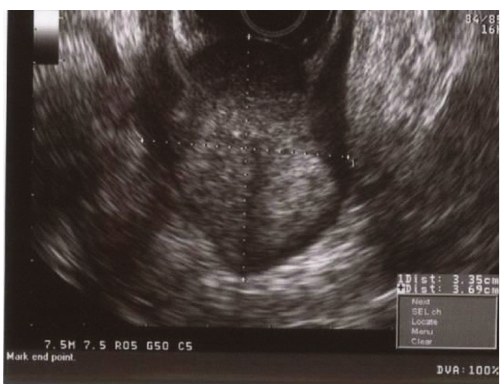
Figure 3: EUS image of antral mass measuring 3 . 4 × 3 . 7cm. Hypoechoic mass emanating from the muscularis propria and with the typical appearance of gastrointestinal stromal tumors.